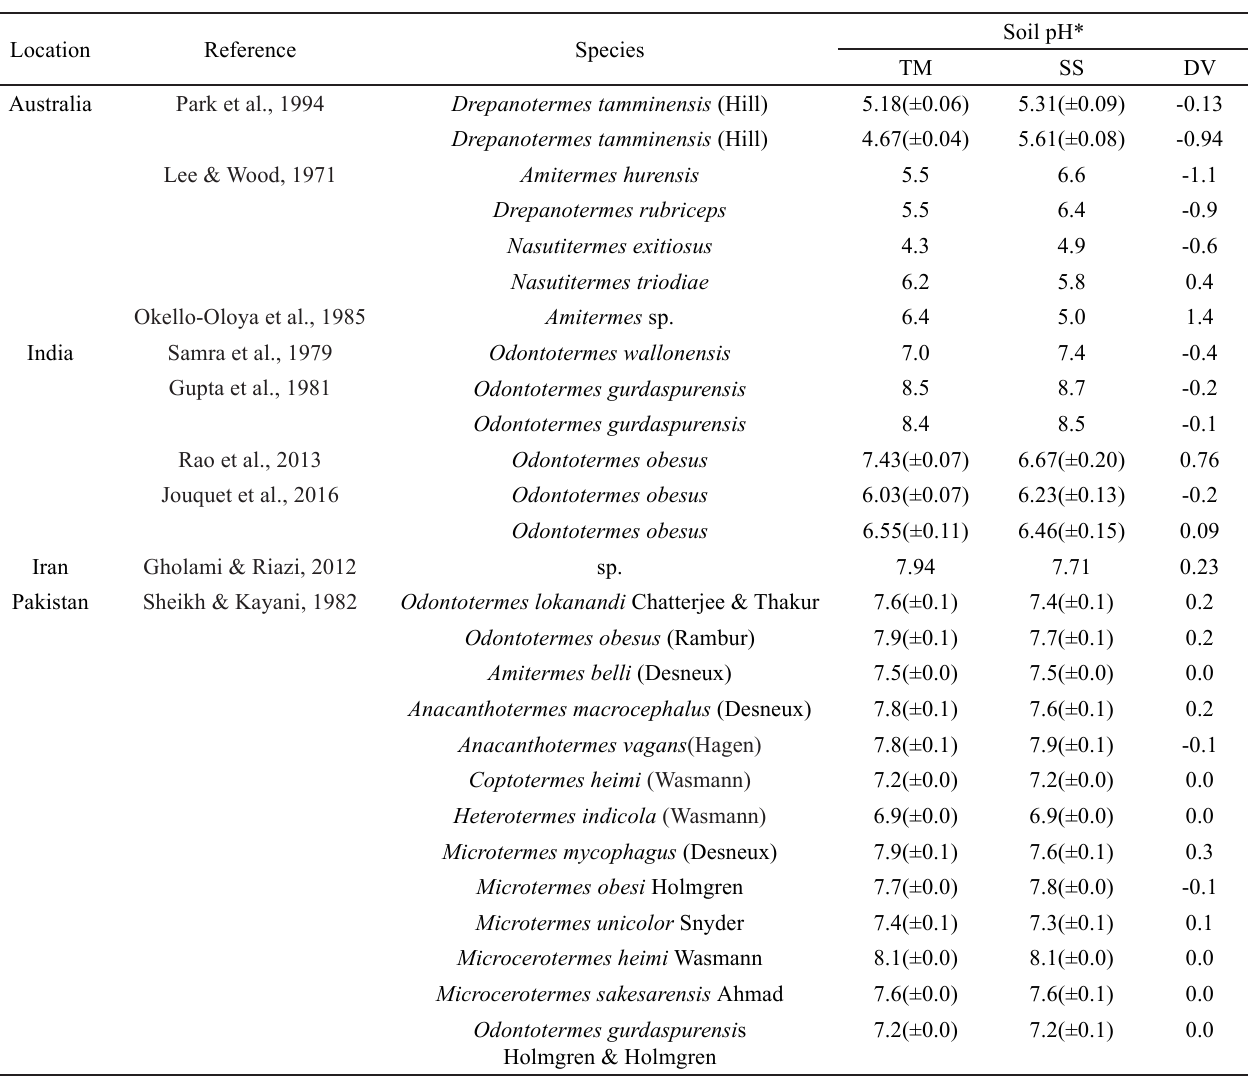
Table 3. Summary for the pHs of termite mounds (TM) and surrounding soils (SS) from literature.